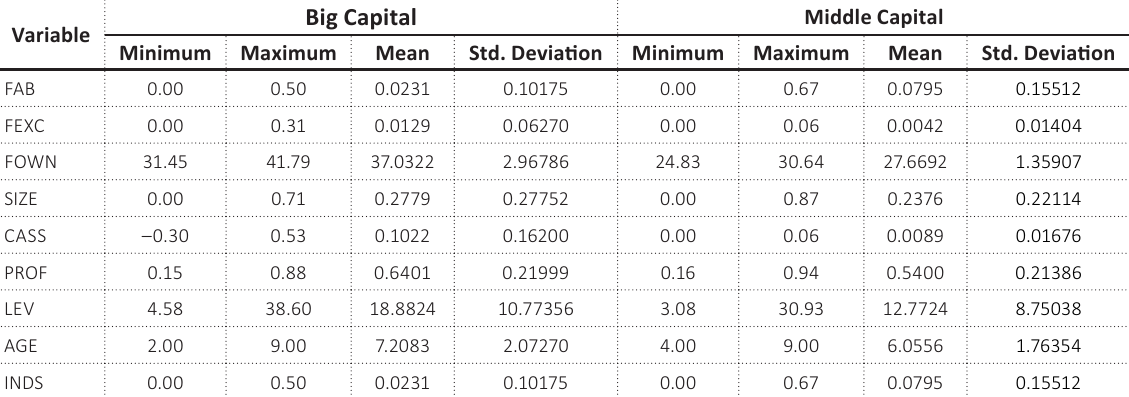
Table 3. Descriptive statistics ( H1 )